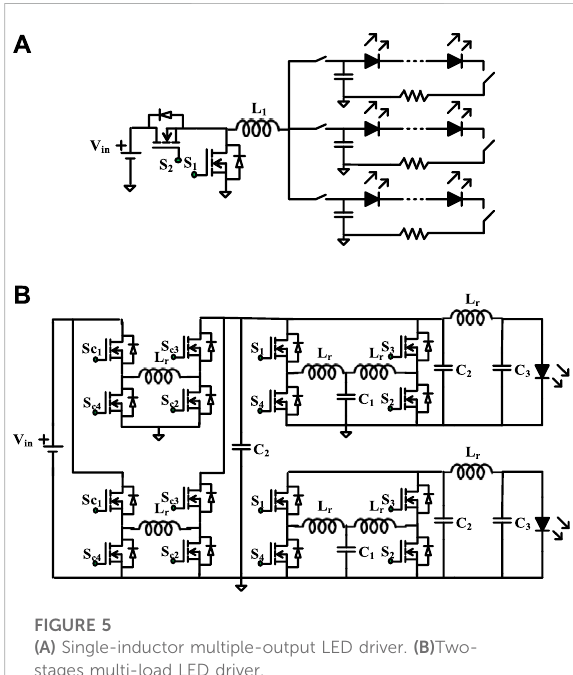
FIGURE 5 (A) Single-inductor multiple-output LED driver. (B) Two- stages multi-load LED